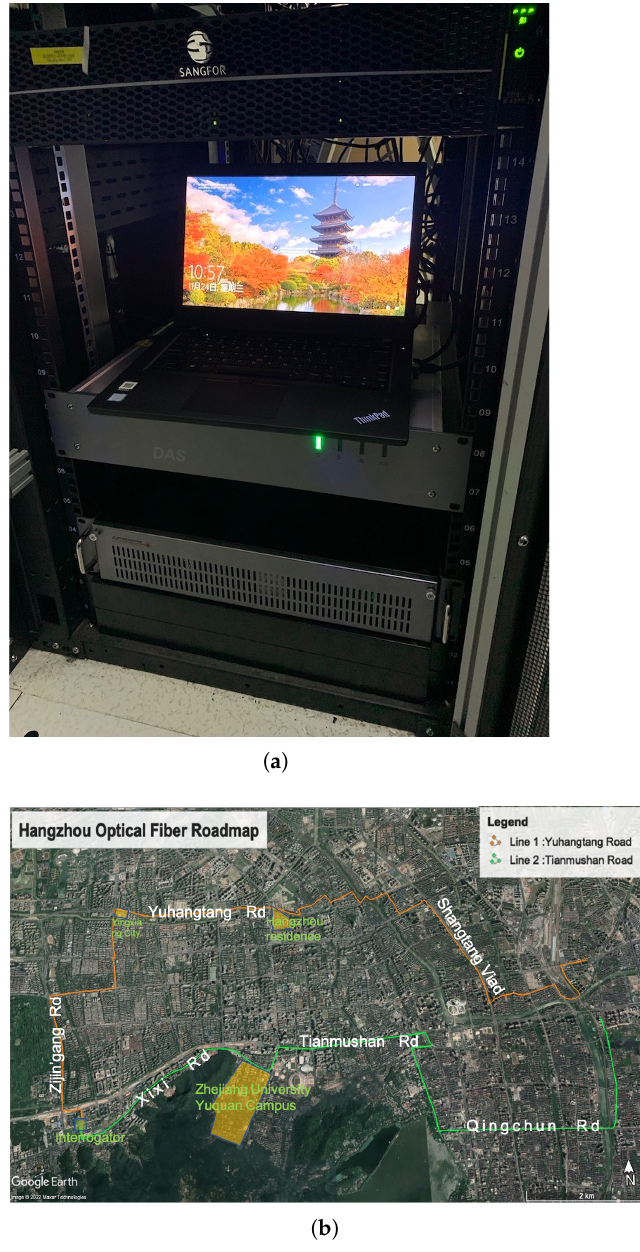
Figure 2. DAS data acquisition in Hangzhou. ( a ) AP-sensing interrogator unit. ( b ) Fiber-optic cable layout. The orange and green lines show the approximate location of the